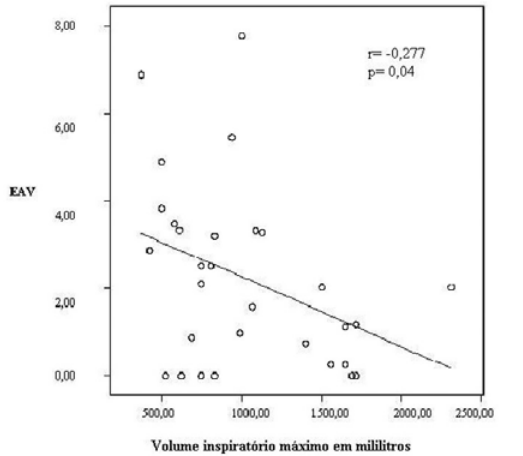
Fig. 2 - Relação entre intensidade de dor e volume inspiratório máximo, r= -0,277; p= 0,04. EAV- escala análoga visual